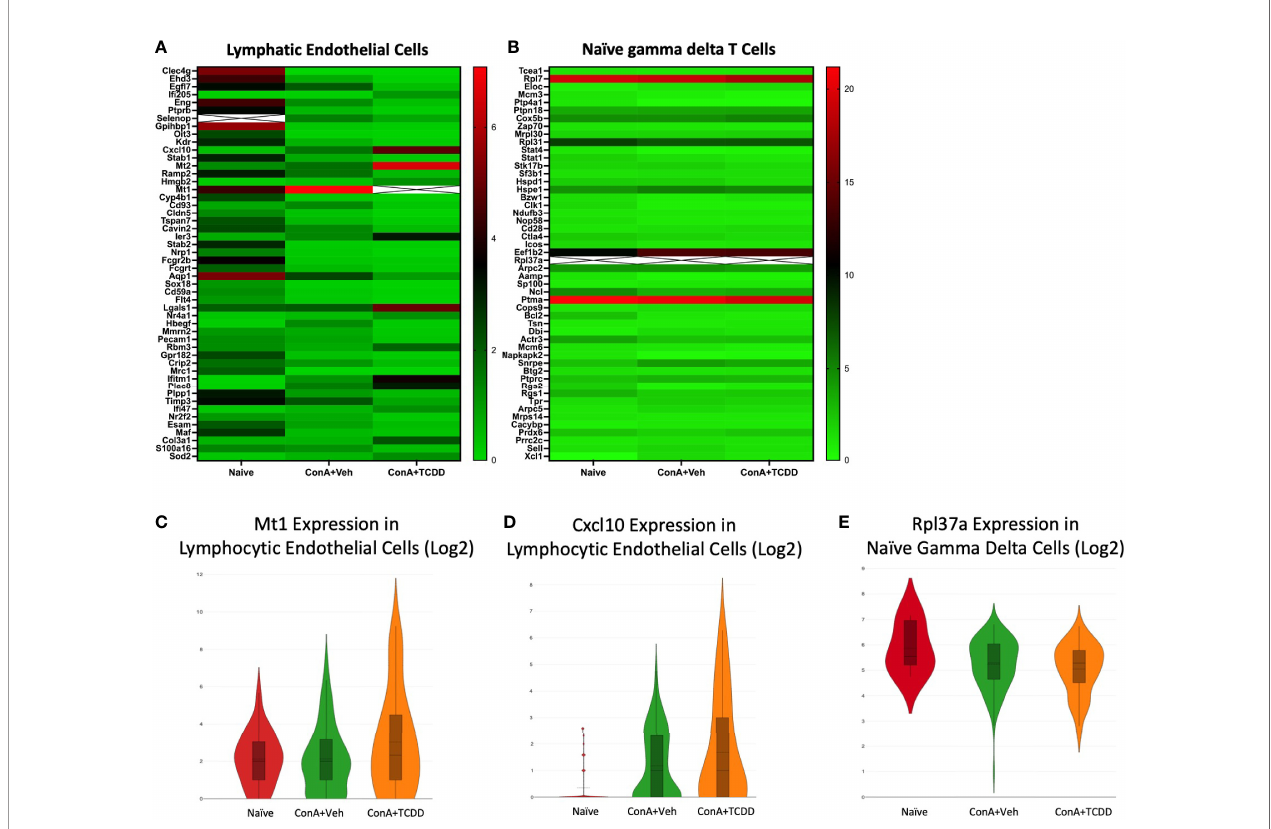
FIGURE 10 | Transcription Pro fi les of Lymphatic Endothelial Cells and Naïve Gamma Delta T Cells. C57/BL6 mice were injected with ConA followed by vehicle or TCDD 1 hour later as described in Figure 1 legend. Liver in fi ltrating cells were isolated and scRNA-seq was performed as described in Methods. Heatmaps consisting of the top 50 differentially expressed genes per treatment were generated using Loupe Browser. Heatmaps of differentially expressed genes from (A) Lymphatic Endothelial Cells and (B) Naïve Gamma Delta T cells. In panels (A, B) , the X marked with some genes represents an expression level over 13. (C-E) Violin plot of Log2 expression of target